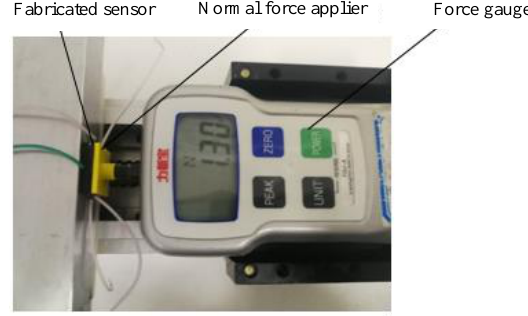
Figure 9. Normal force test platform.